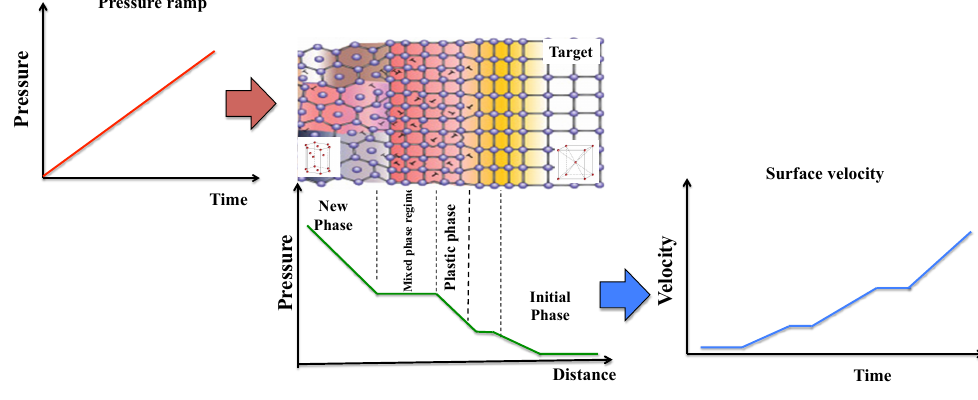
Figure 1. Adaptation from Reference [10] of the schematic relation between the microstructural process occuring during ramp compression of crystal and the target rear surface velocity. When the material compressibility changes, due to an elastic-plastic transition or to a phase transformation, the atomic re-organization, in the compression front, modifies the dynamical response of the crystal causing a variation in the slope the measured rear surface